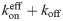
Precision of the hunchback gene transcription readout.A. Comparison of the relative error in the mRNA produced during the steady state of the interphase estimated empirically from data (abscissa) and from theoretical arguments in Eq 4 for a two state switching promoter (blue symbols) using the inferred parameters in Fig 5C (ordinate), and theoretical arguments in Eq 5 for a Poisson-like static promoter (red symbols) using the inferred parameters in Fig 5A (ordinate), in the anterior (circles and squares) and the boundary (diamonds and triangles) regions. The theoretical prediction for the two state promoter shows very good agreement with the data, whereas the Poisson-like promoter shows poor agreement, especially in the boundary region. B. The relative error in the total mRNA produced in cell cycle 13 directly estimated from the data as the variance over the mean of the steady state mRNA production (red line, same data as in A), sum of the intensity over the whole duration of the interphase (blue line) and the total mRNA produced during cell cycles 11 to 13 (green line) for equal width bins equal to 10% embryo length at different positions along the AP axis. Each line describes an average over four embryos (see S9C Fig for the same data plotted separately for each embryo) and the error bars describe the variance. To calculate the total mRNA produced over the cell cycles, we take all the nuclei within a strip at cell cycle 13 and trace back their lineage through cycle 12 to cycle 11. We then sum the total intensity of each nuclei in cell cycle 13 and half the total intensity of its mother and 1/4 of its grandmother. C. Comparison of the relative error in the mRNA produced during the steady state for a two state, k1/k2 = 0, (solid lines) and three state cycle model, k1/k2 = 1, (dashed lines) with the same koneff+koff, for different values of koneff and koff, shows that the three state cycles system allows for greater readout precision. D. A comparison of the theoretical prediction of the steady state relative error rate for the Poisson-like and two state promoter as a function of Pon shows that the Poisson-like promoter is always more accurate. Different values of kon are considered for the two state model.